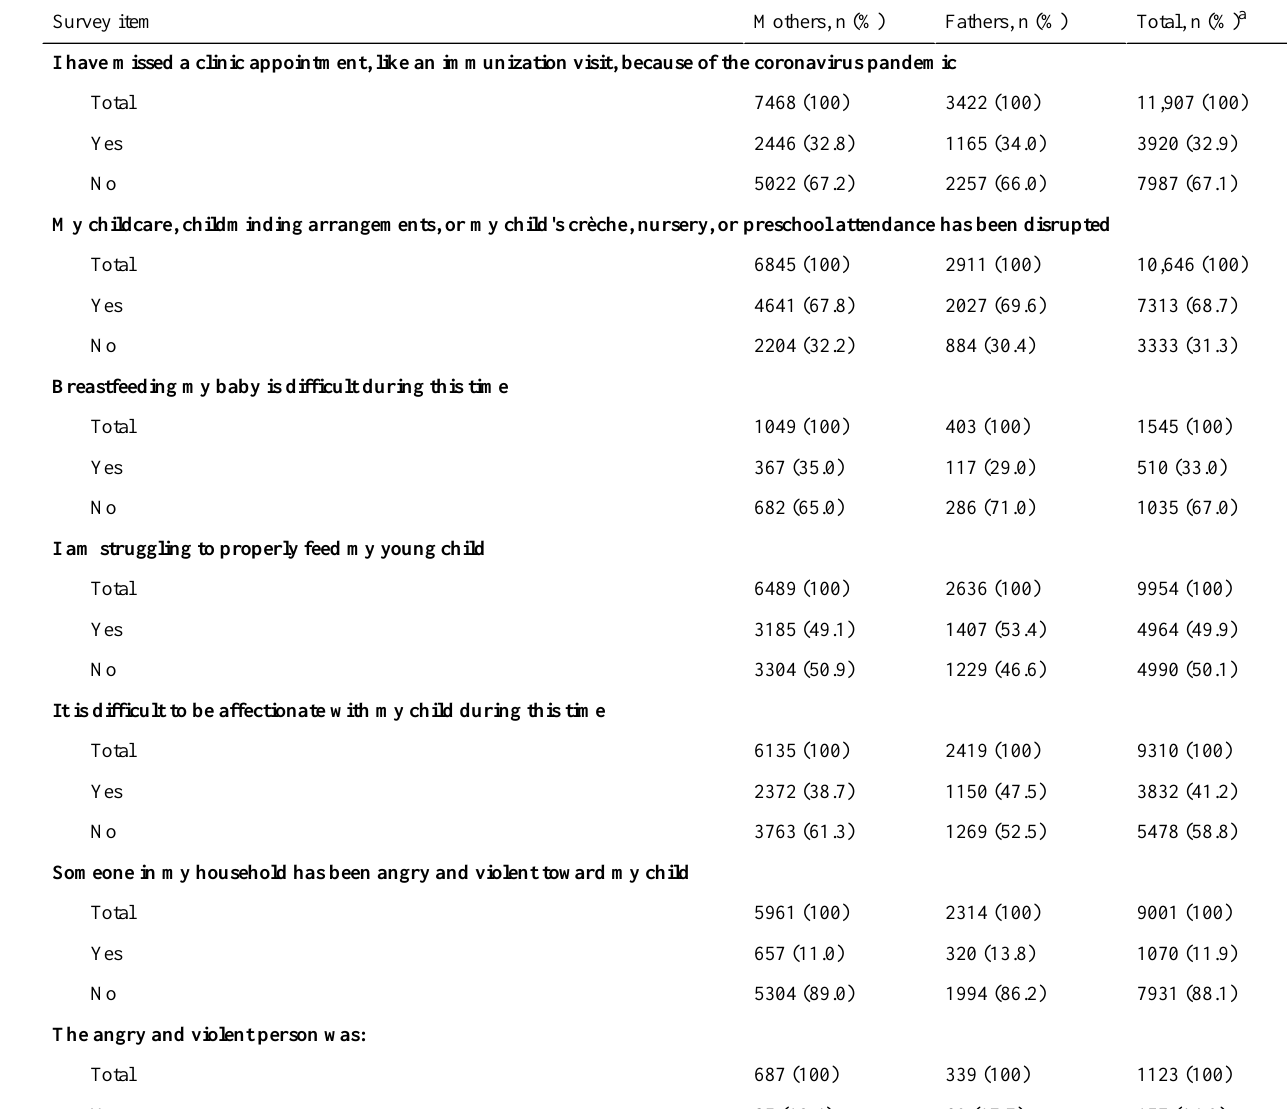
Table 4. Responses regarding challenges and support by parent